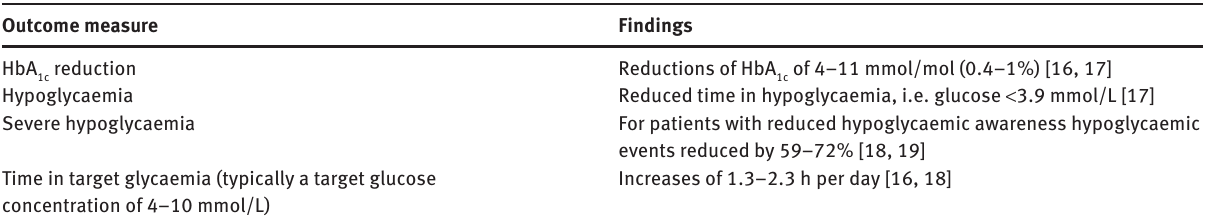
Table 1: Impact of continuous glucose monitoring on glycaemia in patients with type 1 diabetes. Outcome